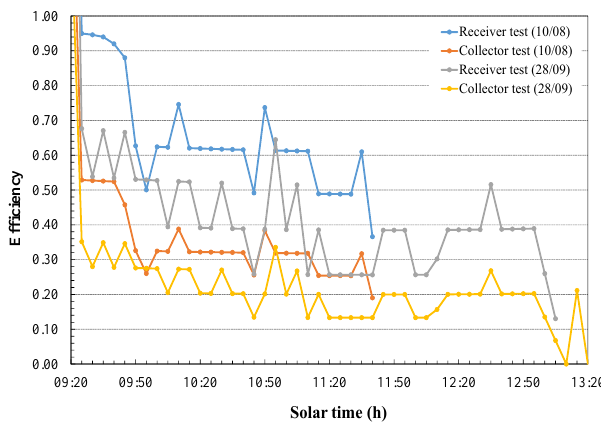
Figure 24. Efficiencies recorded on 10 August and 28